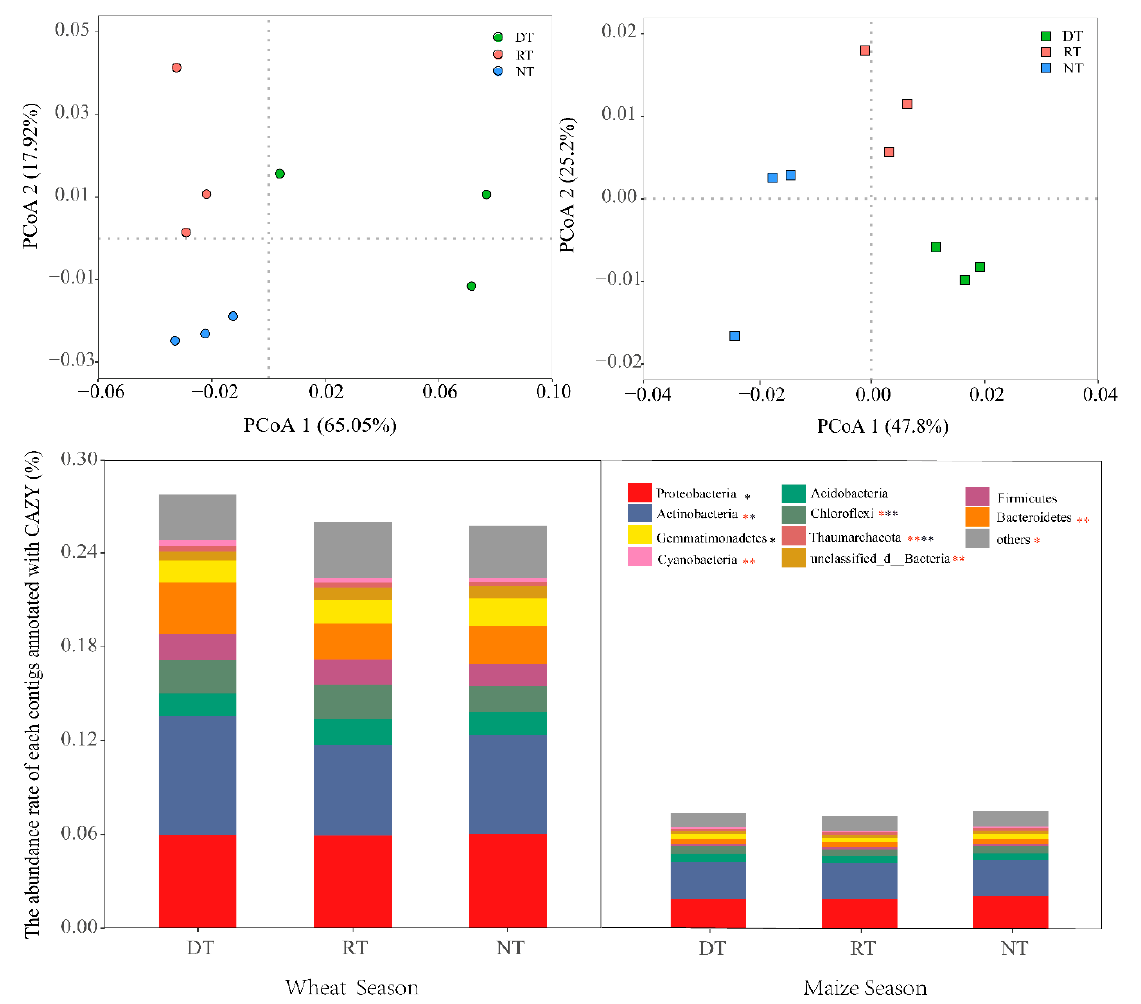
Figure 8. Top : Principal co-ordinate analysis (PCoA) of the microbial community composition relevant to carbohydrate- binding module (CAZy) genes at the phyla level based on Bray–Curtis distance. Bottom : The relative abundance of dominant bacterial phyla with genes relevant to carbohydrate-binding modules (CBMs) (focused on the metabolic pathways represented by >1% of all annotated genes). * Indicates a significant difference between treatments at p < 0.05. ** Indicates a significant difference between treatments at p < 0.01. Red * and black * indicate the wheat season and the maize season, respectively. Left : wheat season, right : maize season.